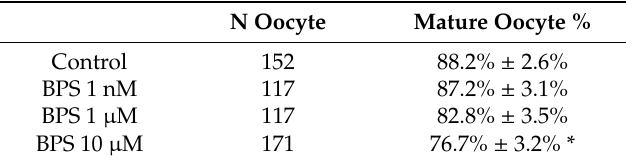
Table 1. Oocyte nuclear maturation stage.